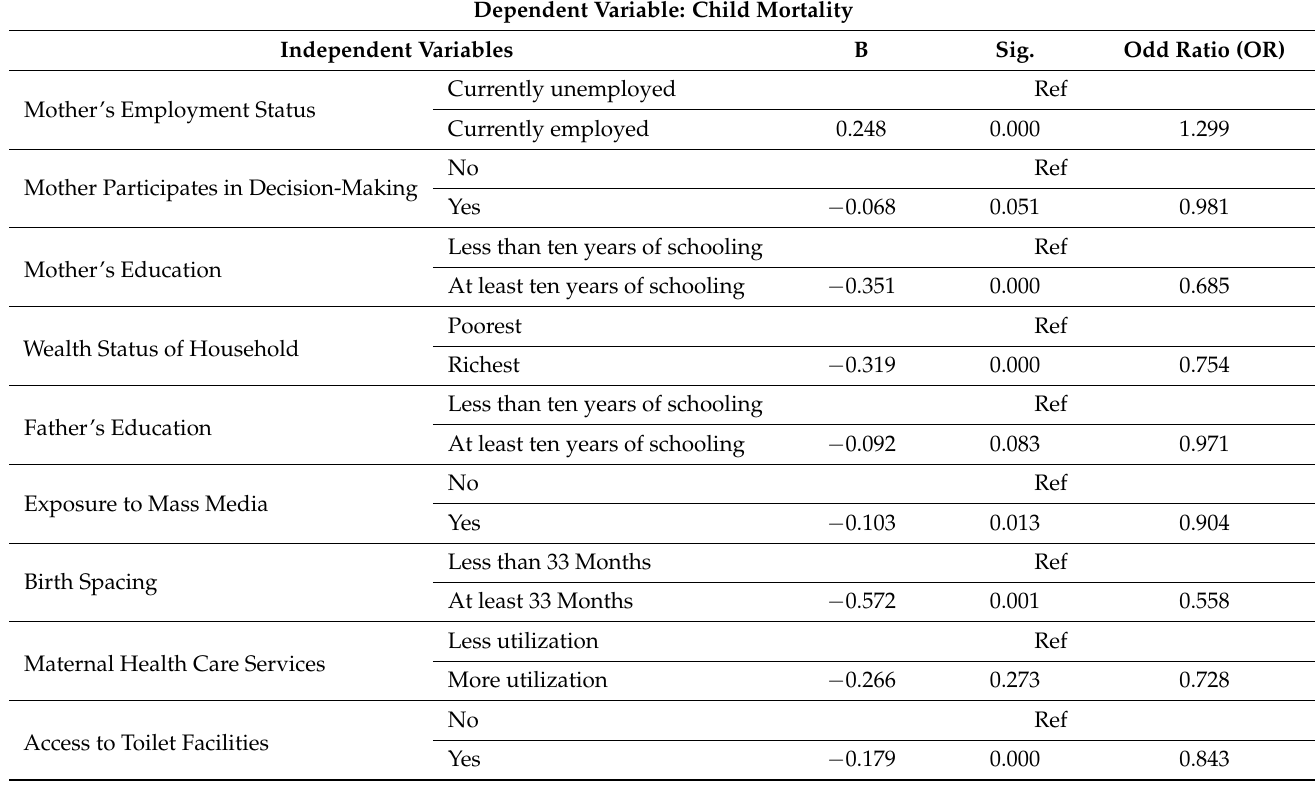
Table 2. The relationship between socio-economic determinants and child mortality: moderating role of birth